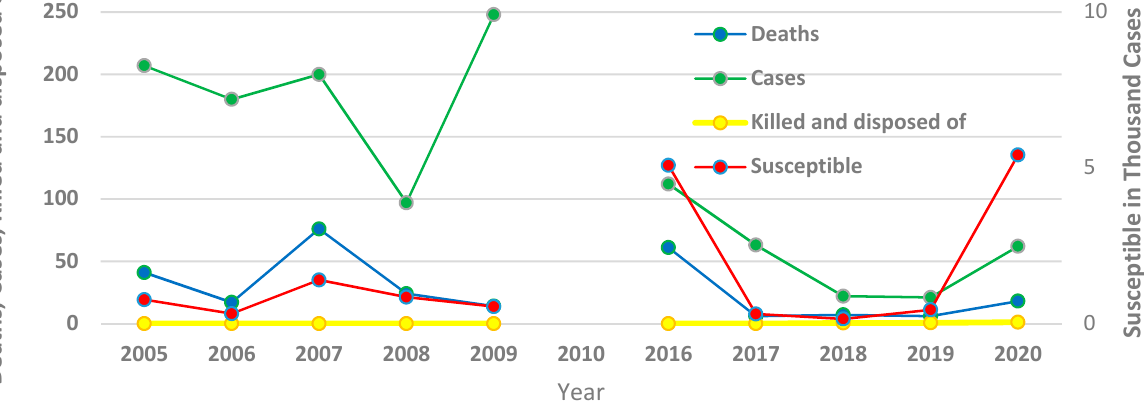
boards/qd-dashboard/ accessed 20 August 2021 [5].